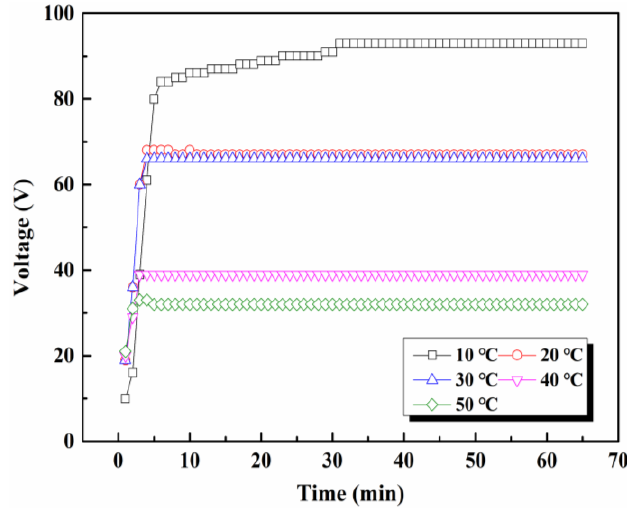
Figure 6. Voltage–time plots of composite anodic films fabricated at different temperatures.